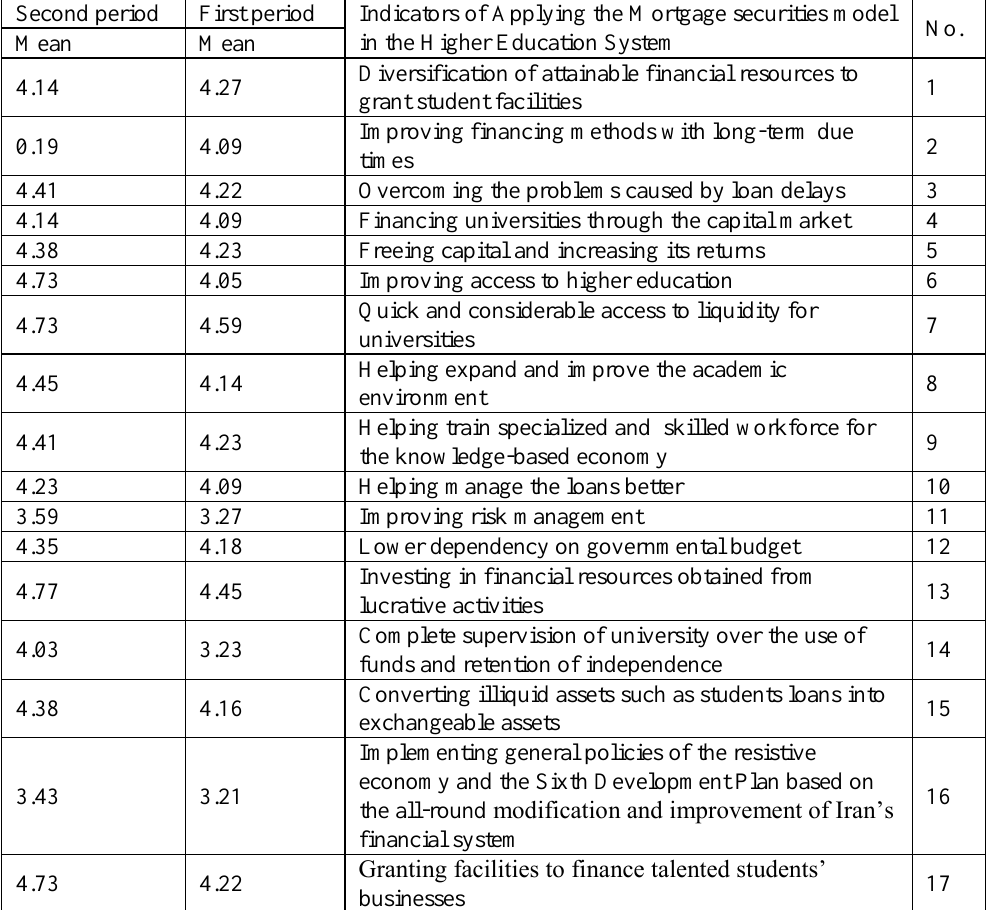
Table 7. Results of Two Rounds of the Delphi Technique – Indicators of Applying the Mortgage securities Model in the Higher Education